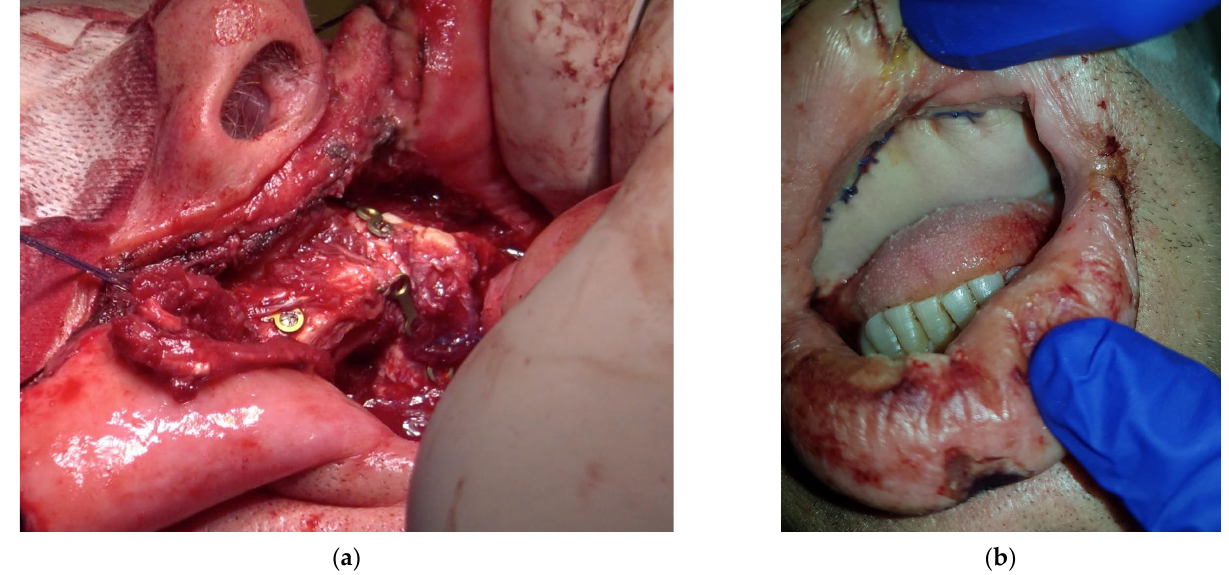
Figure 4. Intraoral images after hard tissue (bone) reconstruction with vascularized fibula free flap ( a ) and soft tissue reconstruction with vascularized free radial forearm flap ( b ).